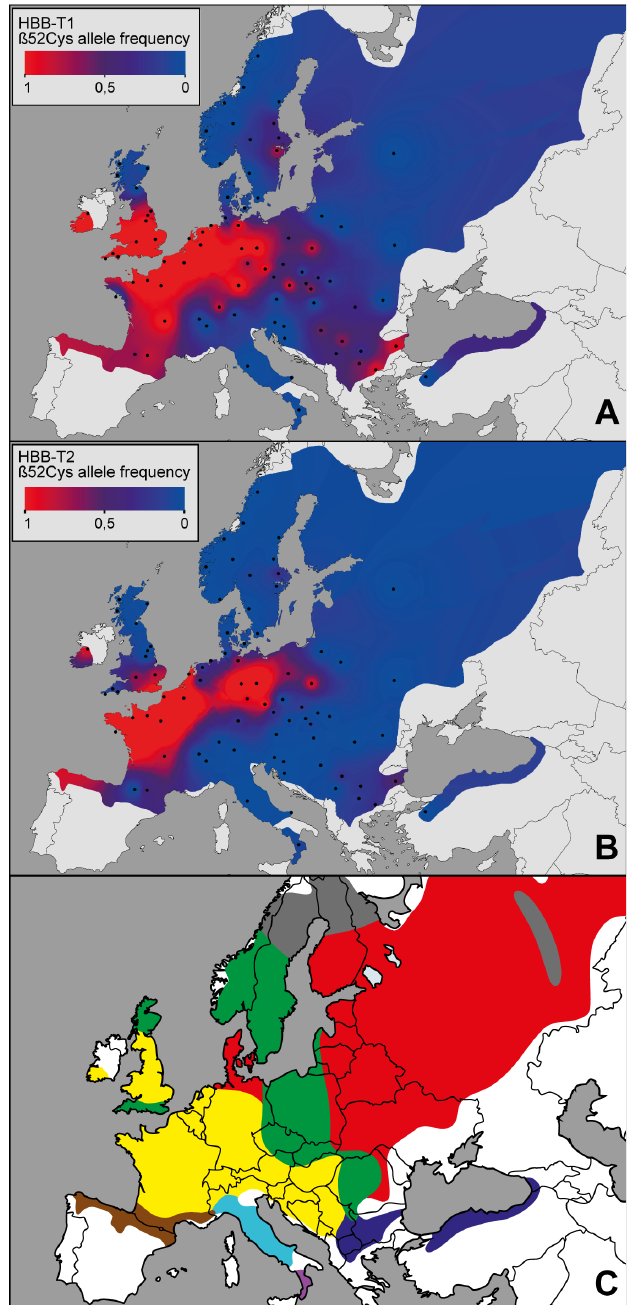
Figure 1. Geographic distribution of the β52Cys allele at HBB-T1 ( A ) and HBB-T2 ( B ) shown as interpolated allele frequency surfaces. Dots represent the location of population samples. Data for Britain were taken from [25]. ( C ) mtDNA lineages distribution modified from [36]. Western lineage in yellow, Carpathian lineage in green, Eastern lineage in red, Balkan lineage in dark blue, Italian lineage in light blue, Calabrian in violet, Pyrenees lineage in brown and introgressed mtDNA from Clethrionomys rutilus in grey colour.